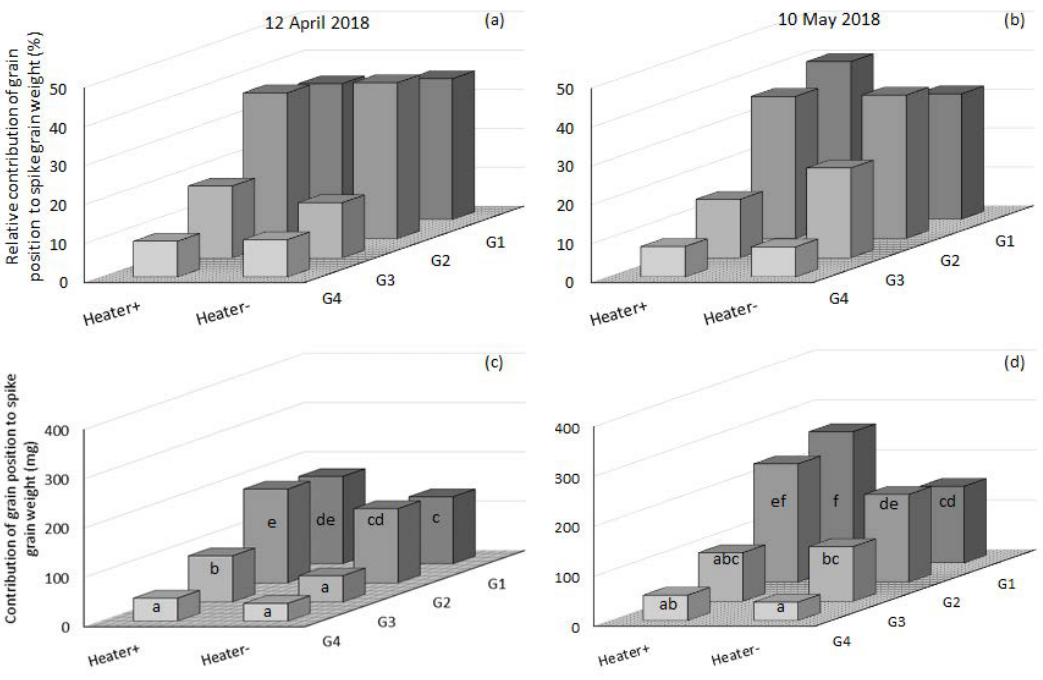
Figure 12. The relative contribution of grain at each position of the spikelet (grain position) to spike grain weight in Wyalkatchem sown in mid-April (12 April 2018 ( a )) and mid-May (10 May 2018 ( b )) sampled from heated and frosted non-heated plots. Absolute spike grain weights for the same sowing dates are shown on ( c , d ) with significance ( p < 0.05) noted by letters with each sowing date compared separately. Relative contributions are calculated from the predicted means of absolute spike grain weights ( n = 45 spikes per data